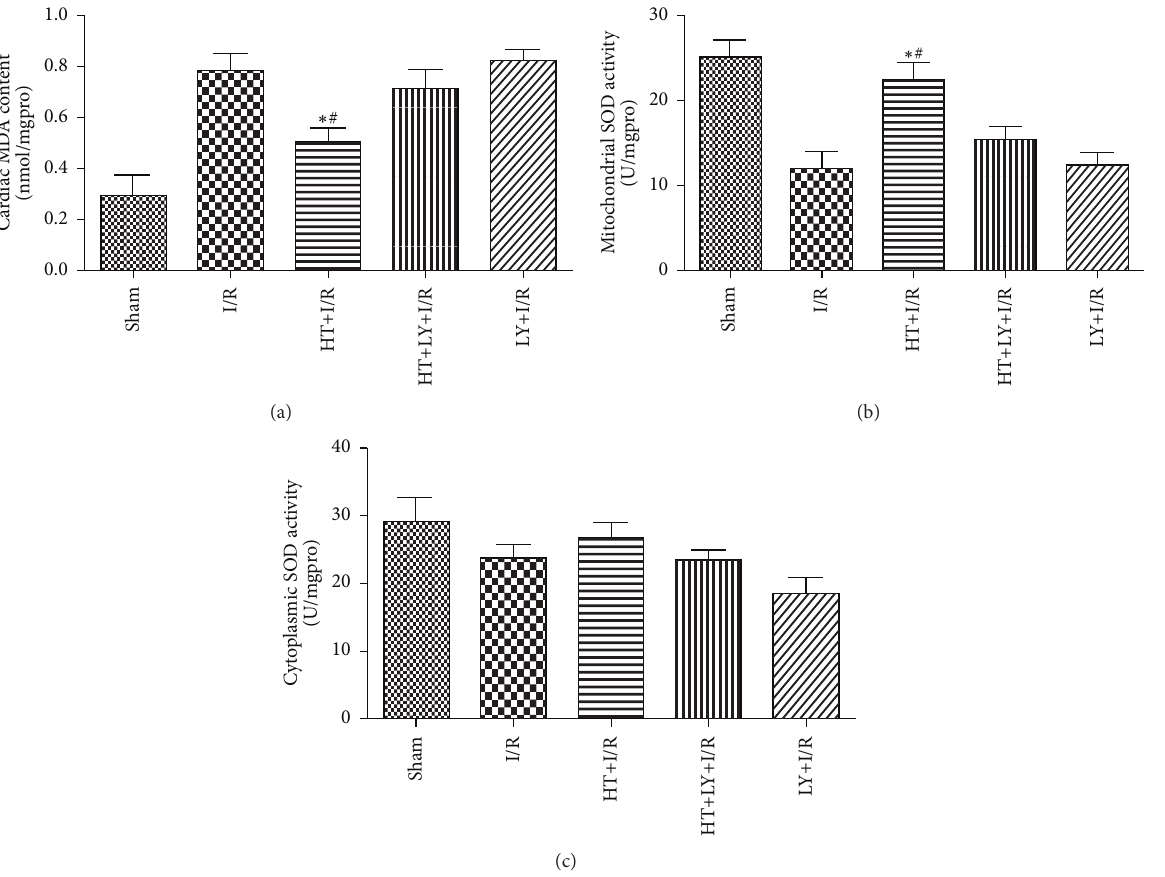
Figure 3: Effects of HT on myocardial levels of MDA (a) and SOD (mitochondrial: (b) and cytoplasmic: (c)) ( 𝑛 = 4 for each group). ∗ 𝑃 < 0.05 versus I/R group. # 𝑃 < 0.05 versus HT+LY+I/R group.